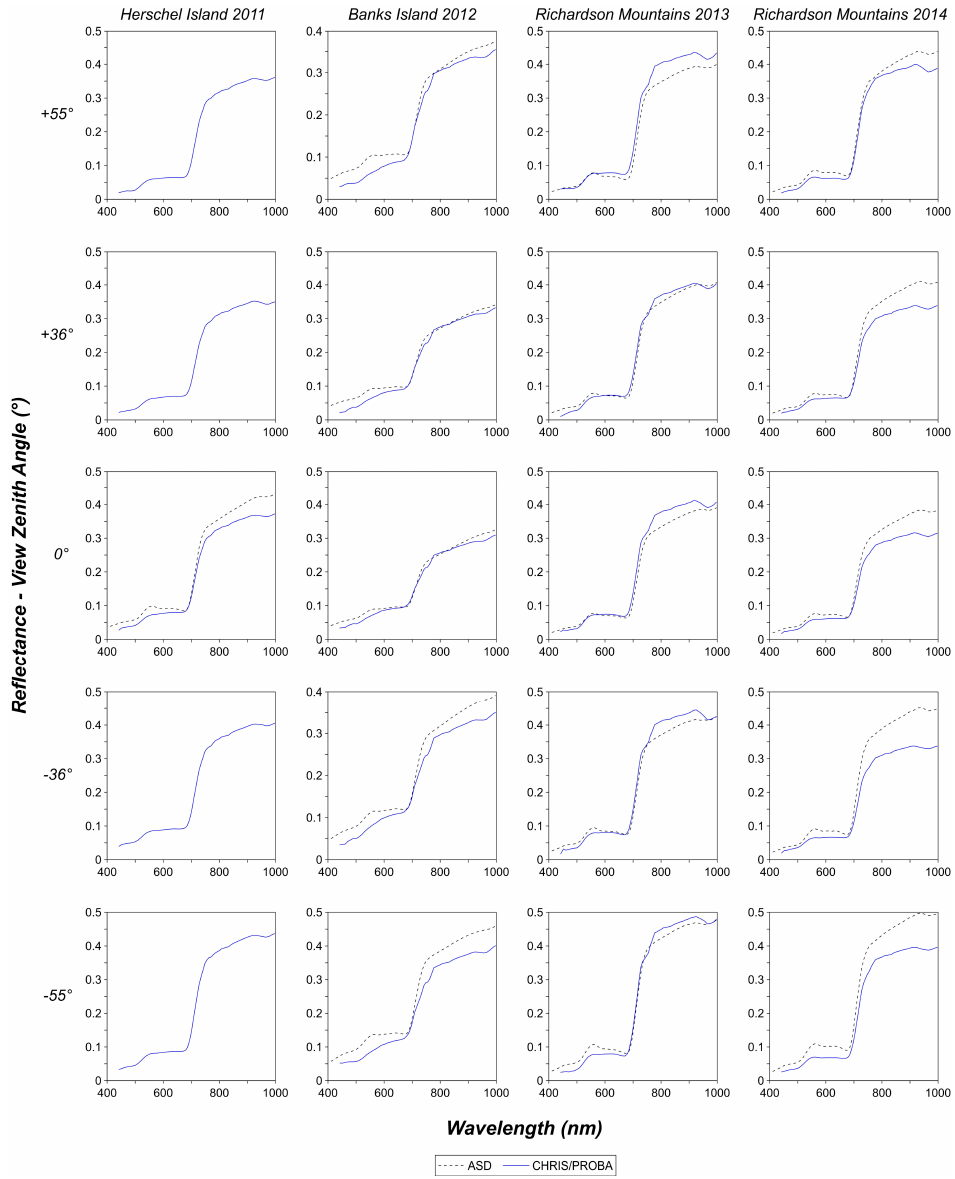
Figure 3. Comparisons of CHRIS Mode-1 (M1) surface reflectance measurements with ground-based multi-angle ASD (Analytical Spectral Devices) spectra acquired at each of the field sites. Herschel Island field spectra were only acquired at nadir.